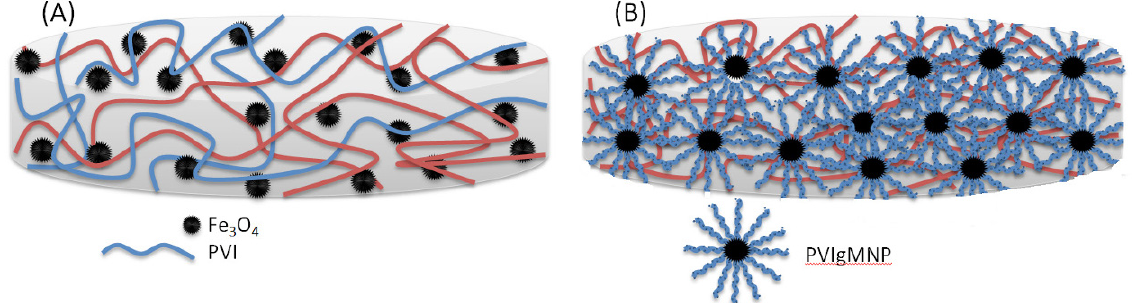
Figure 1. Synthesis of PVIgMNP.